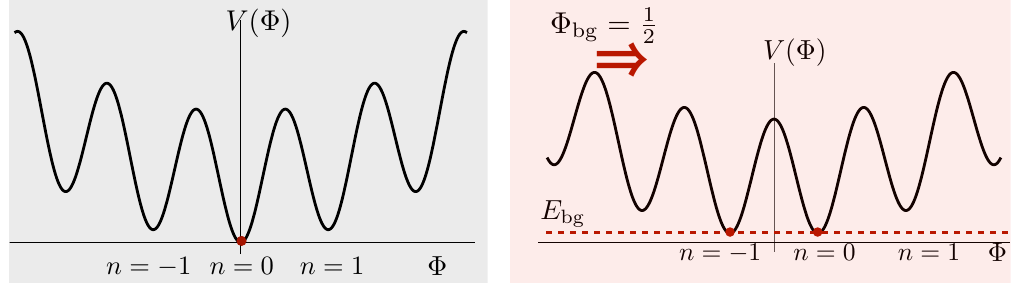
background 2 → ∞ limit. T 2